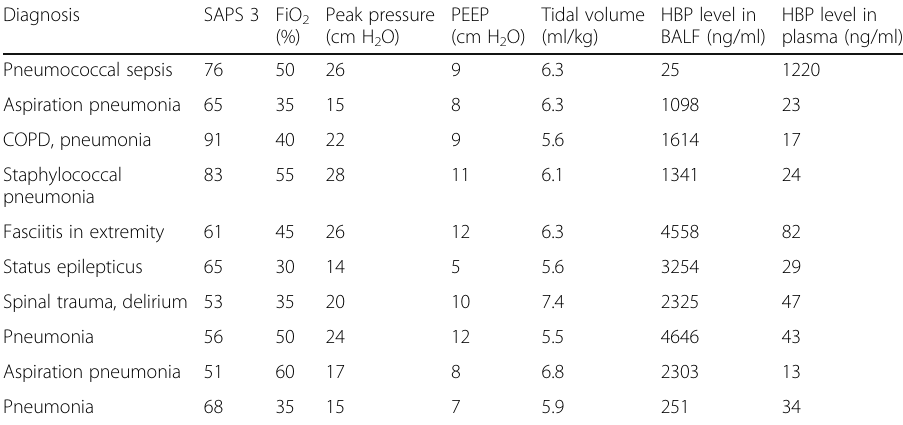
Table 3 Characteristics and levels of HBP in BALF and plasma in intubated ICU patients Diagnosis SAPS 3 FiO 2